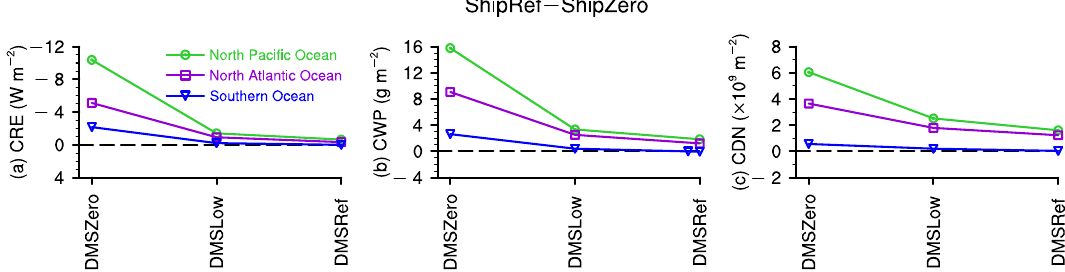
Figure 8. Impacts of DMS emissions on cloud responses to international shipping emissions. (a) Cloud radiative effects at the TOA (Wm − 2 ) , (b) column-integrated cloud water path (gm − 2 ), and (c) column-integrated cloud droplet number ( × 10 9 m − 2 ). The green, purple, and blue curves respectively represent quantities area-averaged over the North Pacific Ocean (NPO), the North Atlantic Ocean (NAO), and the Southern Ocean (SO), which are shown as red boxes in Fig. 1a. These results are from MARC